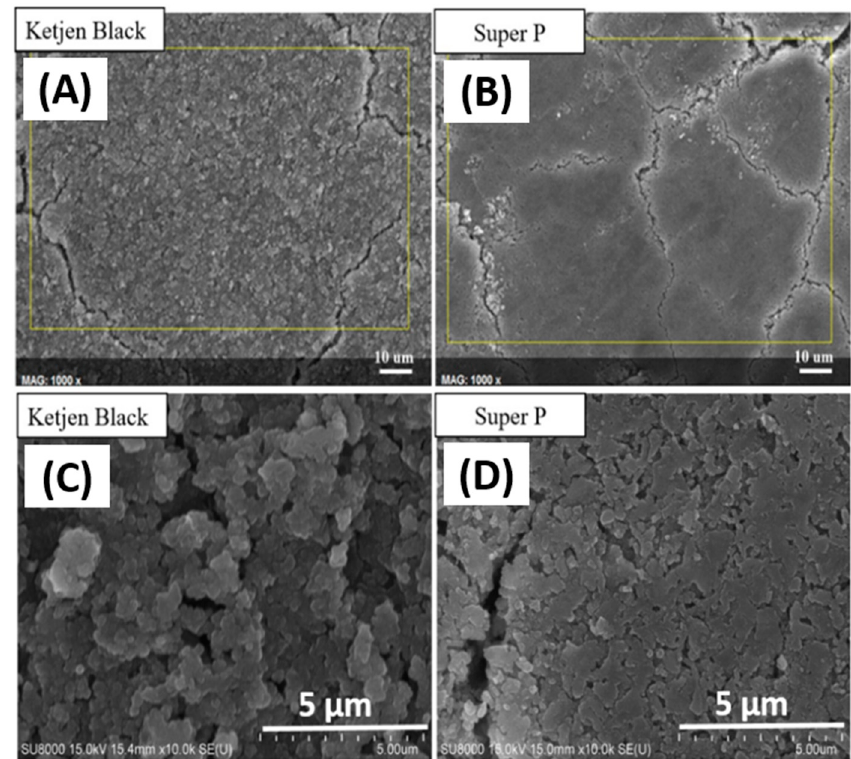
Figure 7. The SEM images of pyrolytic silicon-based anodes after the first discharge–charge cycle. Images ( C,D ) are enlarged images of ( A,B ), respectively. Images ( A,C ) are anodes with the KB additive. Images ( B,D ) are anodes with the Super P additive.